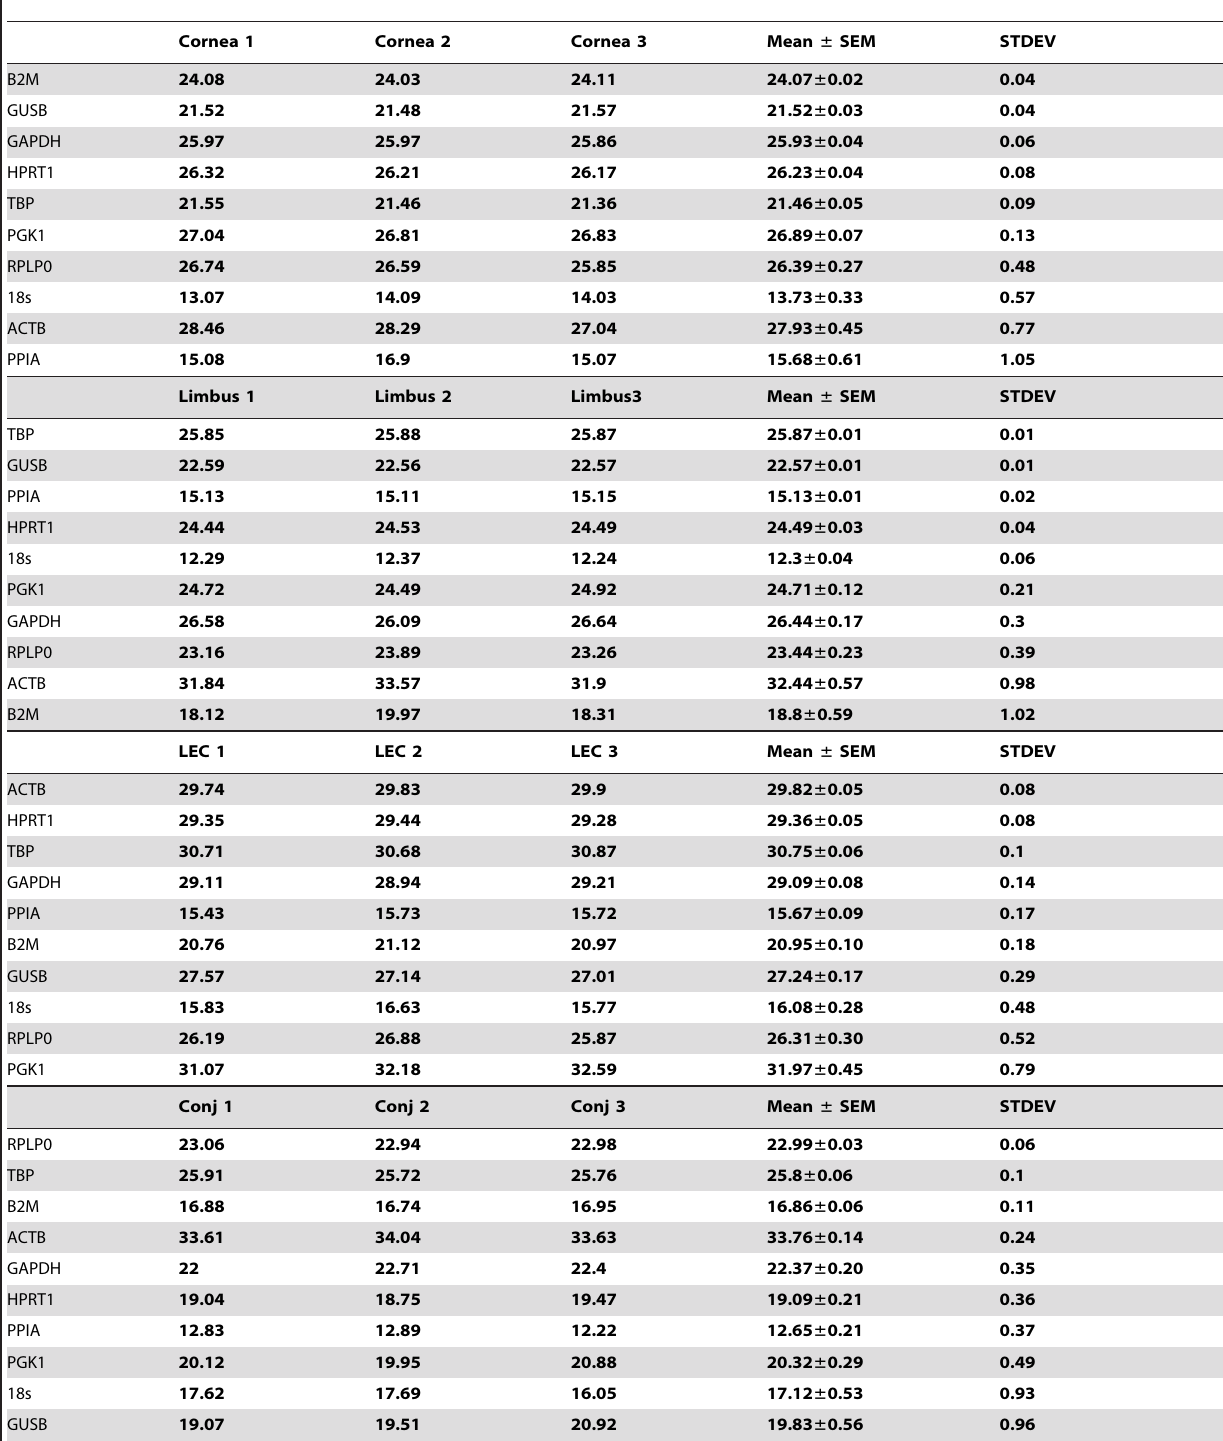
Table 2. Cp values of endogenous control genes in ocular surface epithelial regions.